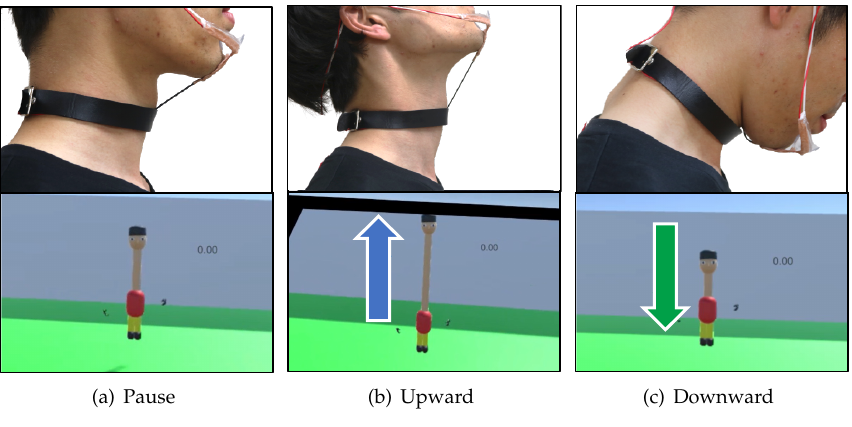
Figure 14. Operation with a natural